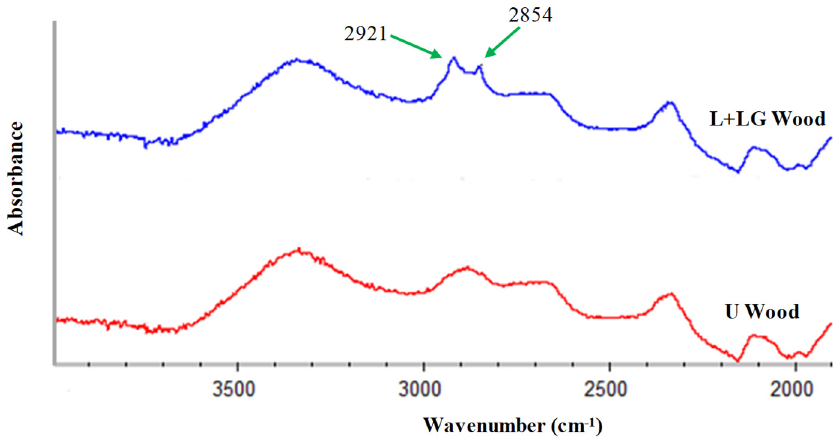
Figure 4. FT-IR spectra between 2000 and 4000 cm − 1 of untreated beech wood veneers (U Wood) and beech wood treated with laccase and lauryl gallate (L+LG